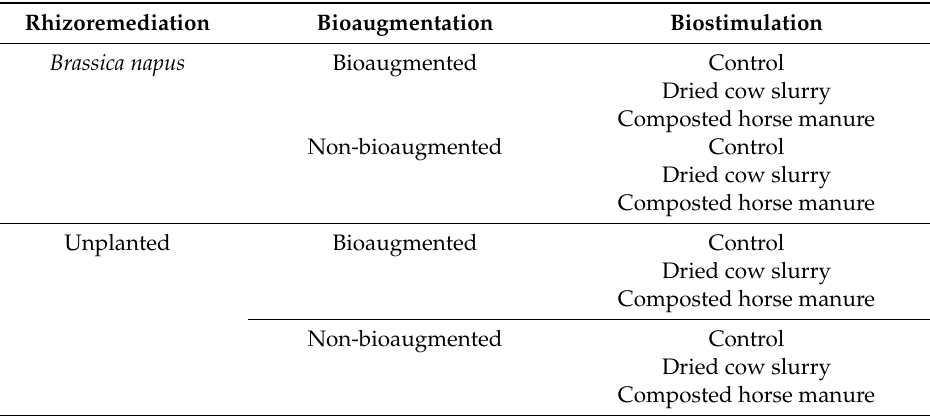
Table 1. Experimental